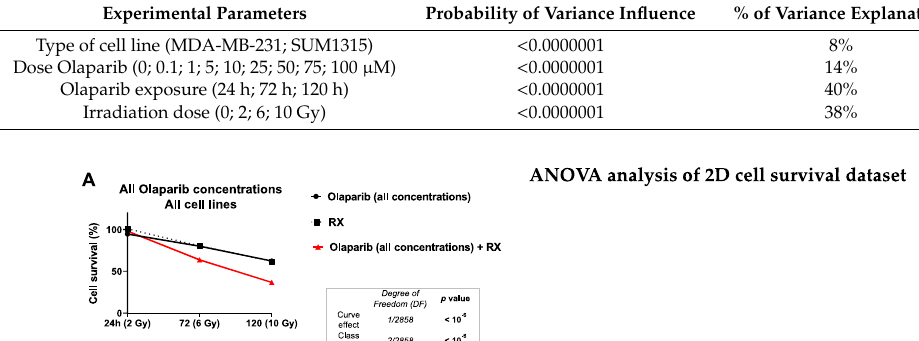
Table 2. Multivariate ANOVA results obtained from the SRB monolayer cell survival dataset. Experimental Parameters